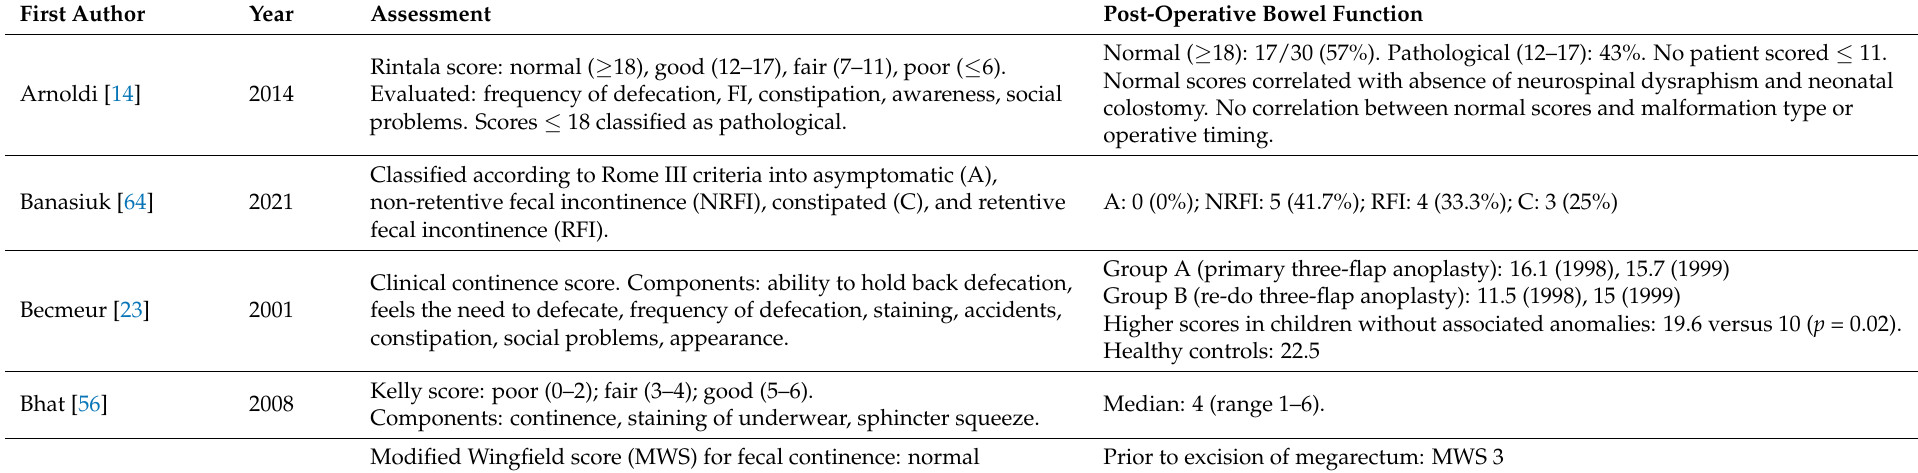
Table 5. Reported post-operative bowel function: assessment measures and